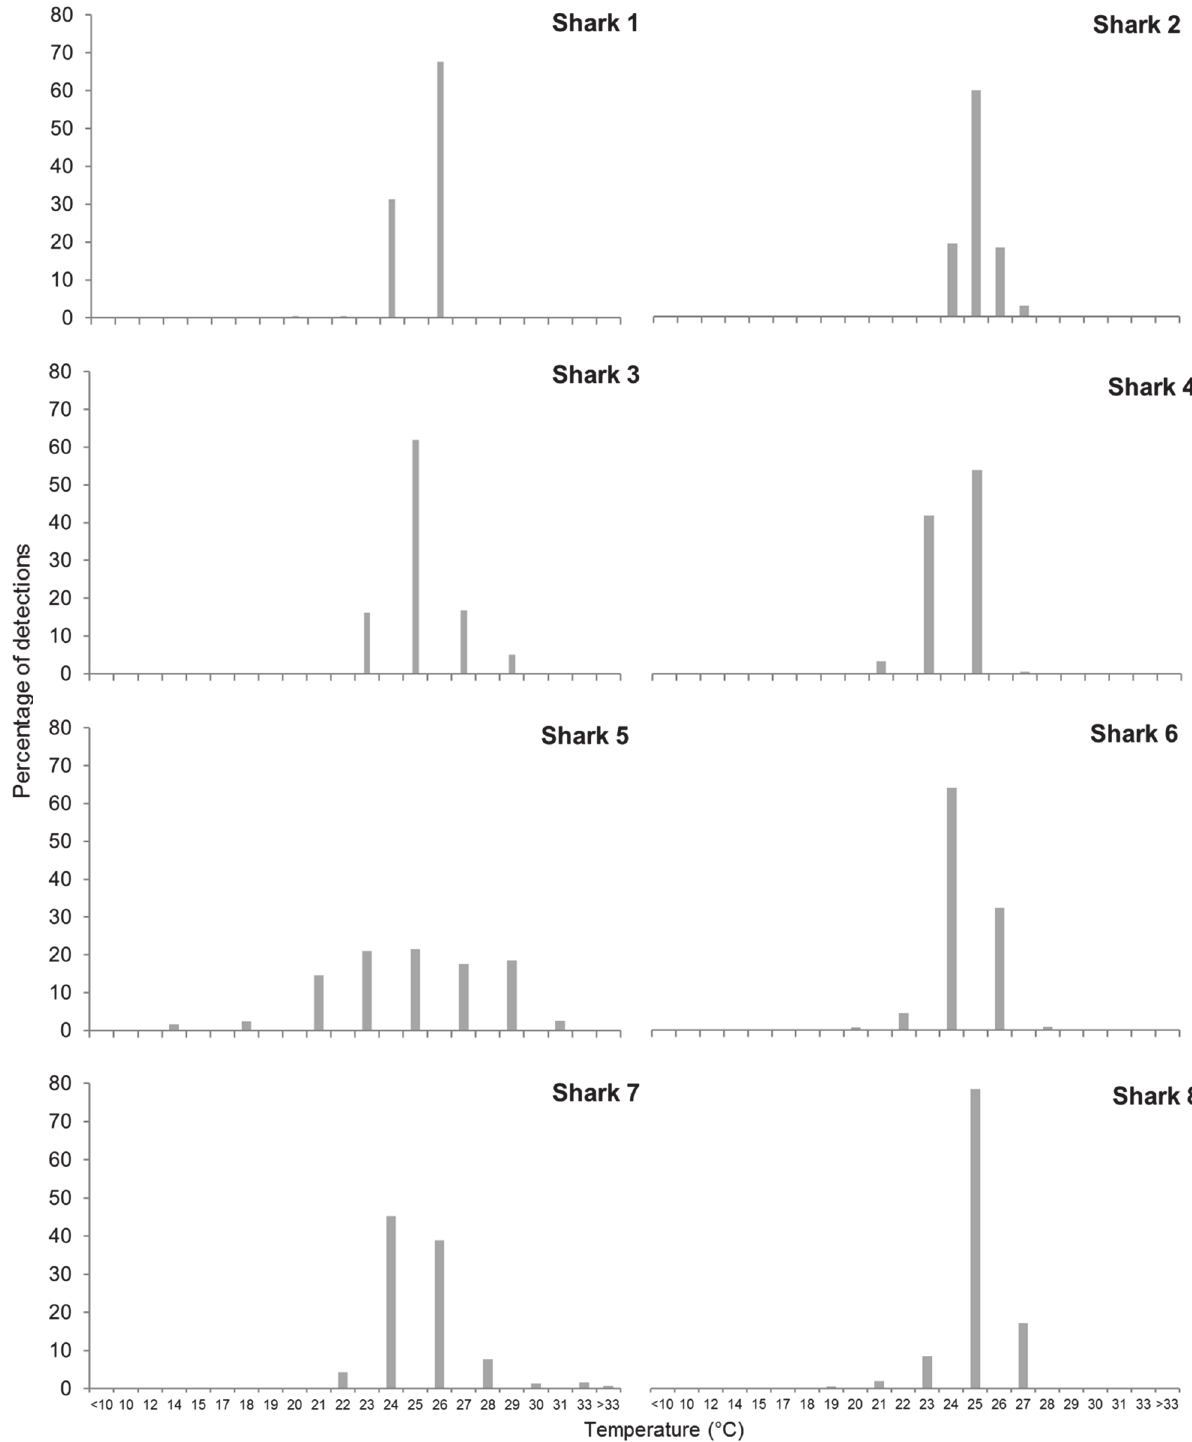
Fig 3. Time spent in each temperature bin. Plots show the percentage of time spent within the specified temperature bins for each tiger shark (ID number in the top right hand corner of each plot).